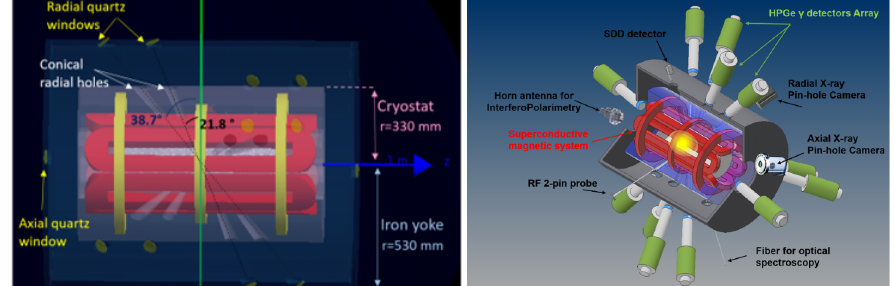
Fig.1 a) Drawing of the PANDORA magnetic system made of 3 superconducting coils (in yellow) for axial confinement and a superconducting hexapole (in red) for radial confinement. The magnetic system is contained in a single cryostat shown in light grey. An iron yoke is used to confine the magnetic field (dark blue area). Conical line of sight are created in the yoke and the cryostat to have direct access to the plasma chamber and used for HPGE detection system and diagnostics. b) Drawing of the PANDORA setup with HPGe around the trap and some diagnostic